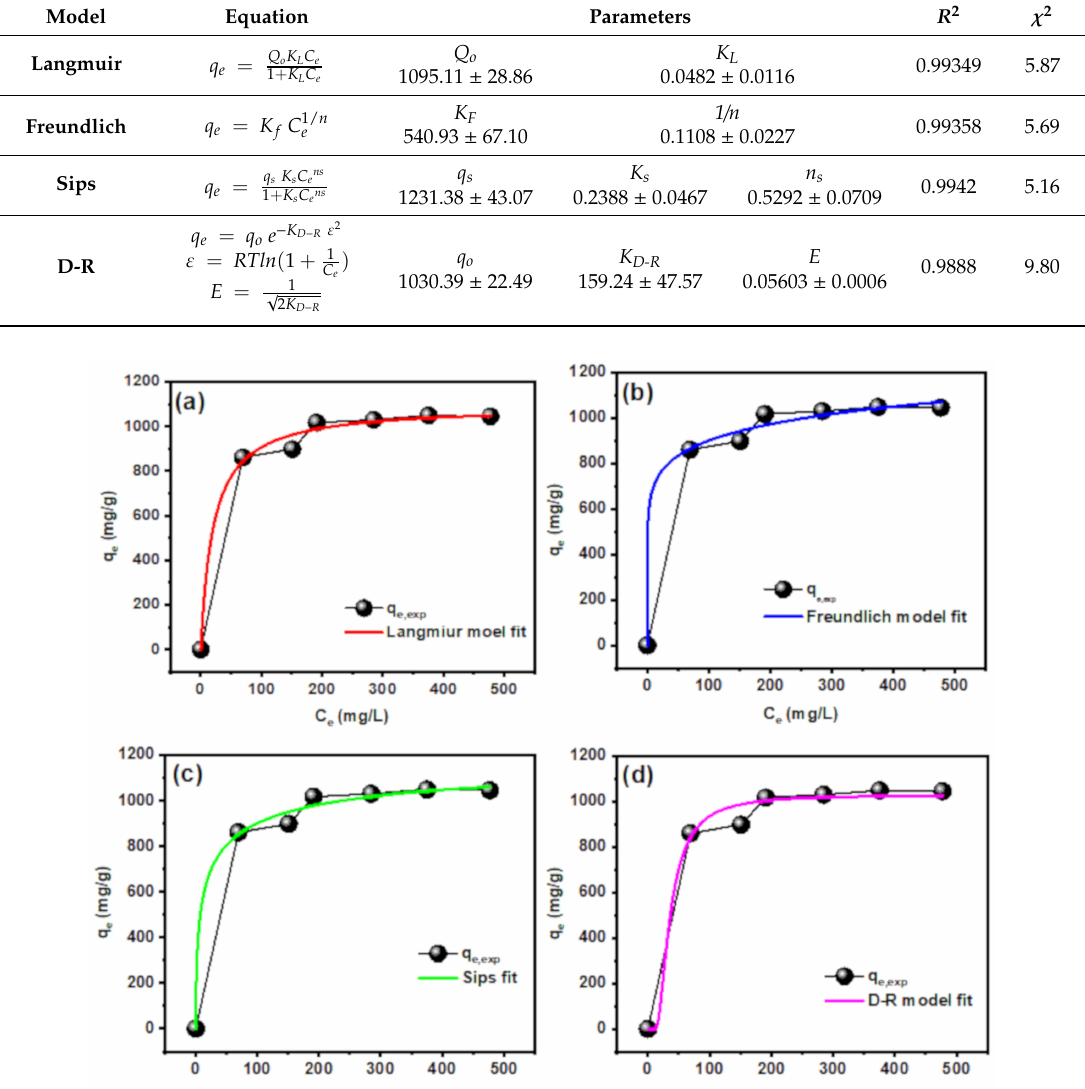
Table 1. Equations and parameters of non-linear isotherm models of adsorption MB dye onto CT- g -PAA / O-ECNFs hydrogel nanocomposite.